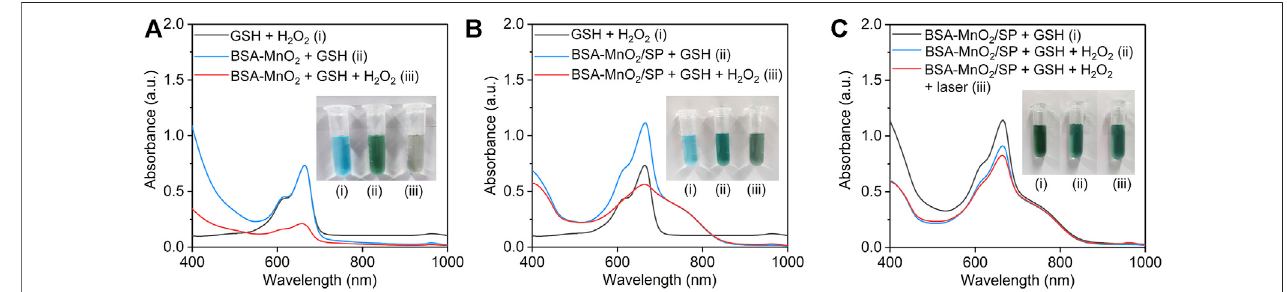
FIGURE 4 | Evaluation of OH generation ef fi cacy. (A) Evaluation of OH generation via BSA-MnO 2 nanoparticle – mediated Fenton-like reaction using MB as an indicator. (B) Evaluation of OH generation via BSA-MnO 2 /SP nanocomposite – mediated Fenton-like reaction using MB as an indicator. (C) Evaluation of OH generation for BSA-MnO 2 /SP nanocomposites without or with 808 nm laser irradiation (1.0 W/cm 2 ) for 5 min.